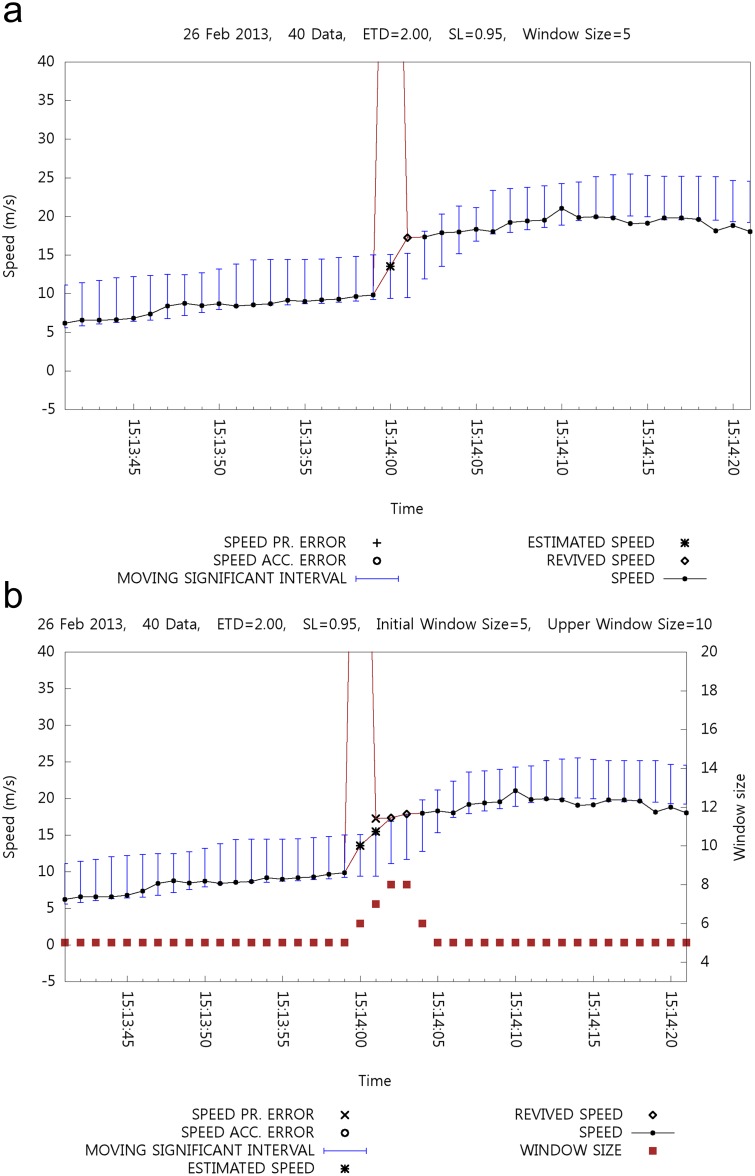
Case1: Effect of Window Size Adjustment.